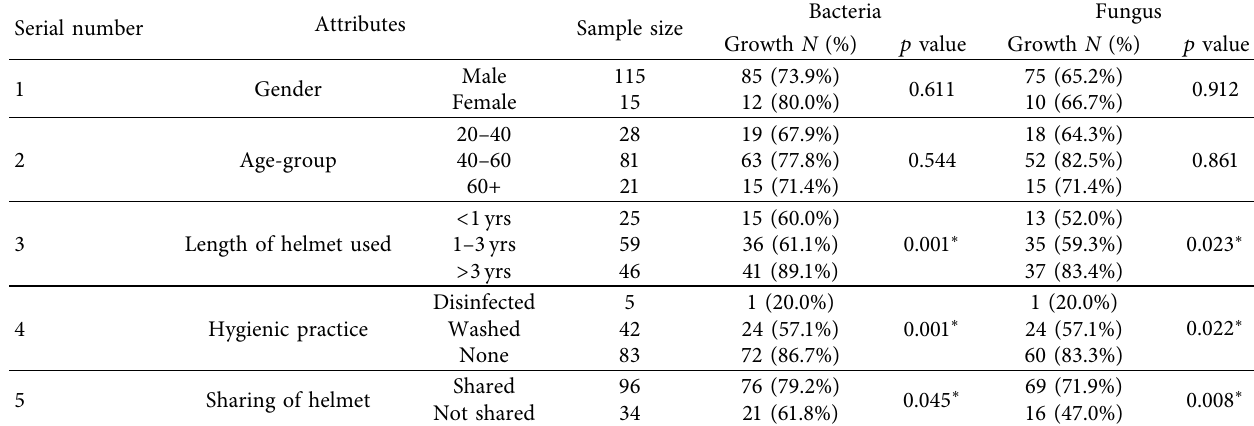
Table 3: Distribution of microbial growth with different variables.